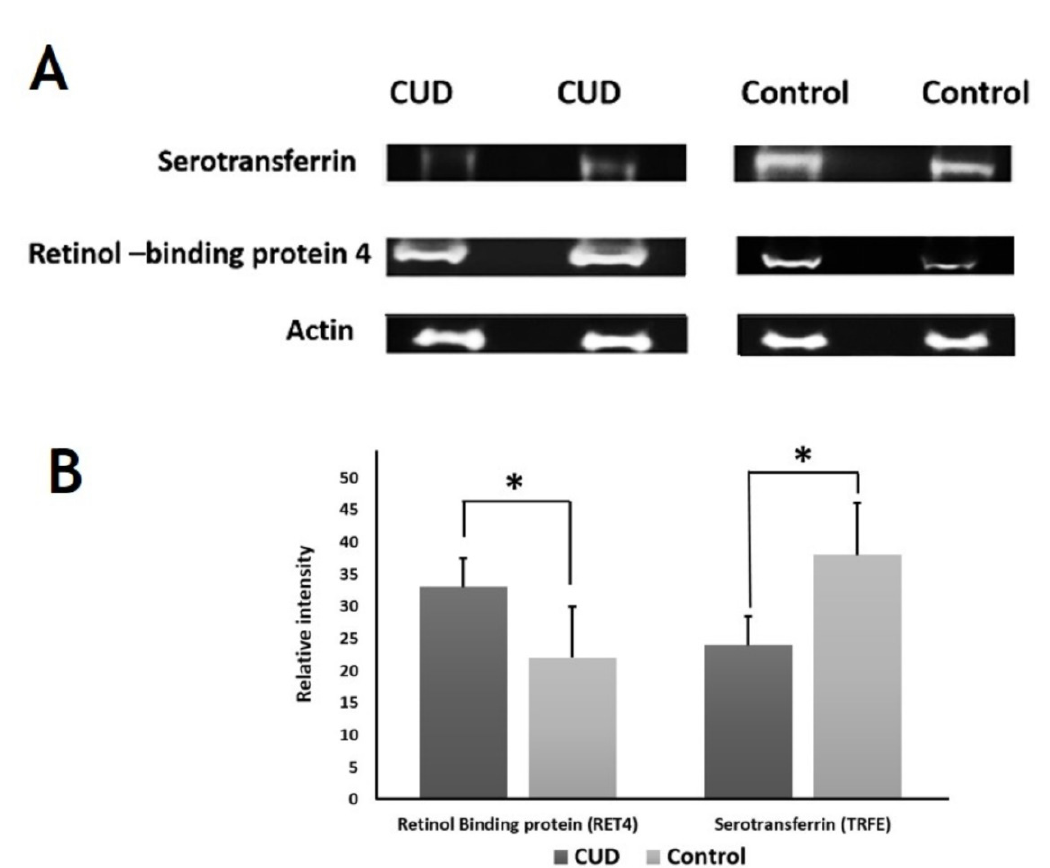
Figure 7. Western blot assay of the chosen proteins identified by 2D-DIGE analysis. Samples from CUD patients and controls were pooled together and used for western blot analysis. The results of Western blot study were similar to the findings of 2D-DIGE ( A ). Graphical analysis of the relative expression data of normalized protein blots between the control and CUD. The presented data are shown as histograms of the mean ± SD and * p < 0.05 ( B ).